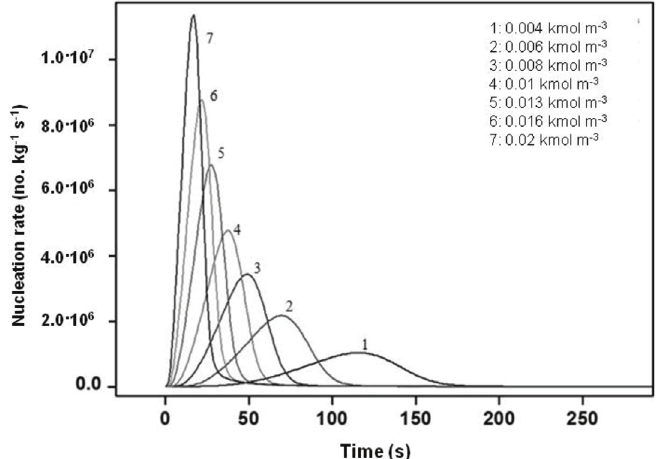
Fig. 3 – Nucleation rate simulated with PBM for initial con- centration of reactants CaCl and NaOx varied from 0.004 to 2 0.02 kmol m –3 in single feed semi-batch crystallizer with feed rate of 5 mL min